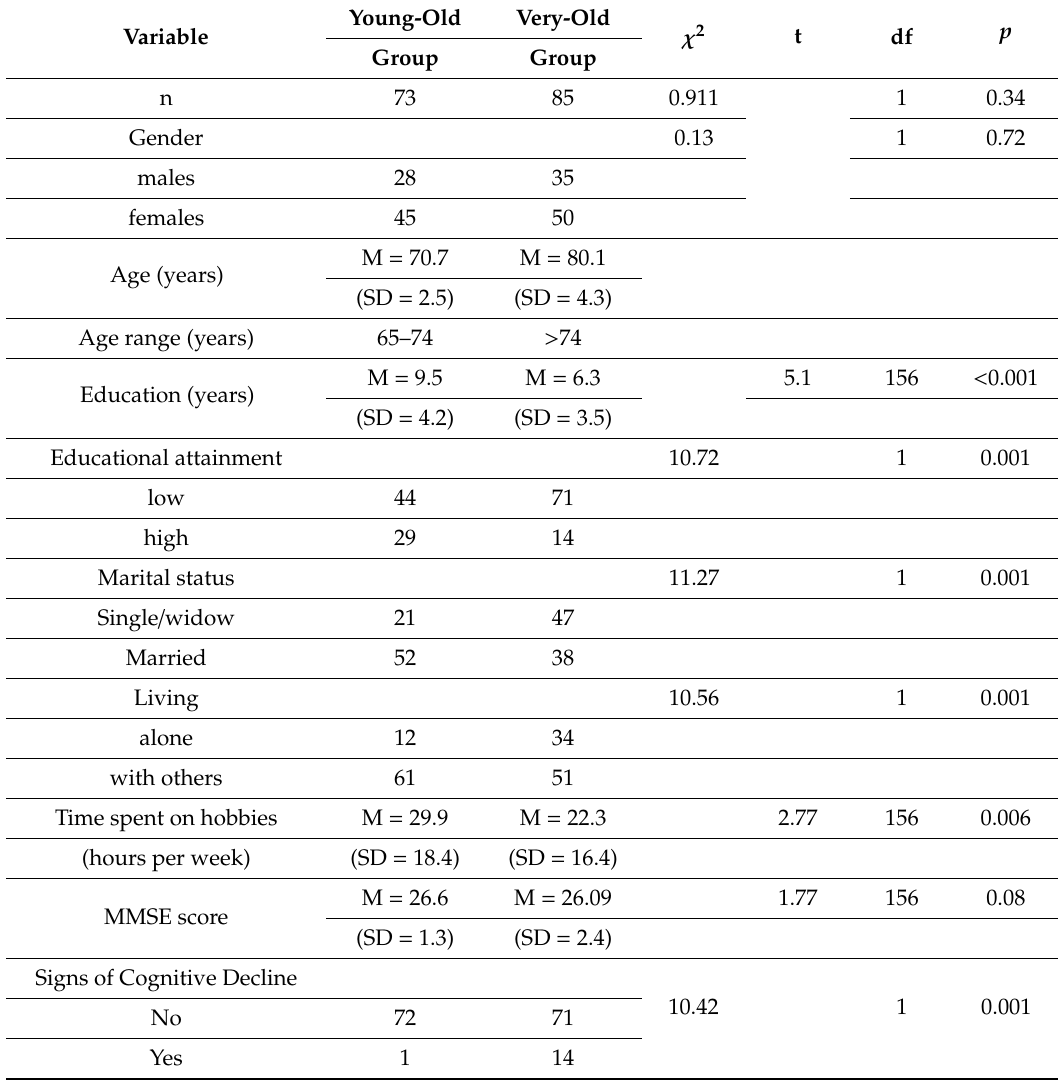
Table 1. Socio-demographic information and global cognitive e ffi ciency (i.e., Mini-Mental State Examination (MMSE)) scores collected from all the participants in the